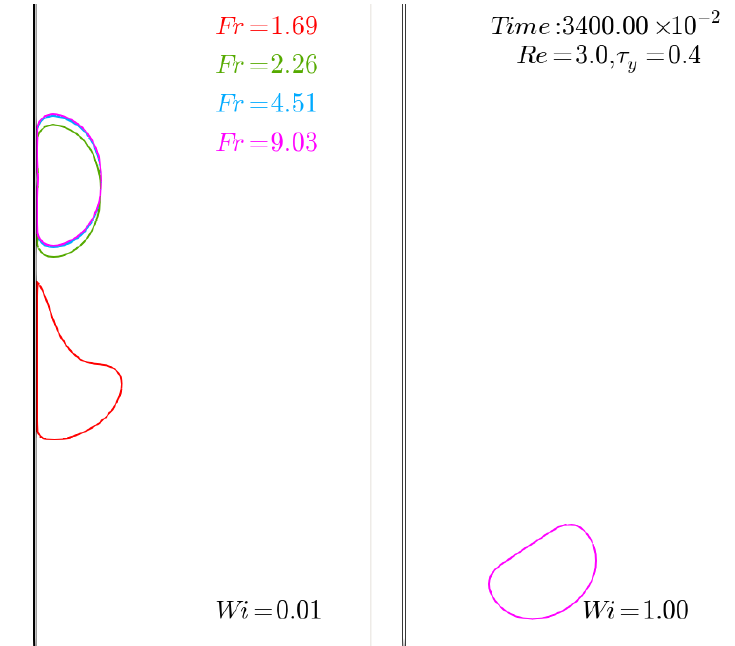
Figure 7. Collision of drops on a vertical wall for fixed values of the Reynolds, Re = 3, and plastic numbers, τ y = 0.4 and the following values of the Froude number, Fr = { 1.69;2.26;4.51;9.03 } . ( left column ) Wi = 0.01; ( right column ) Wi = 1.0. Dimensionless time, t =